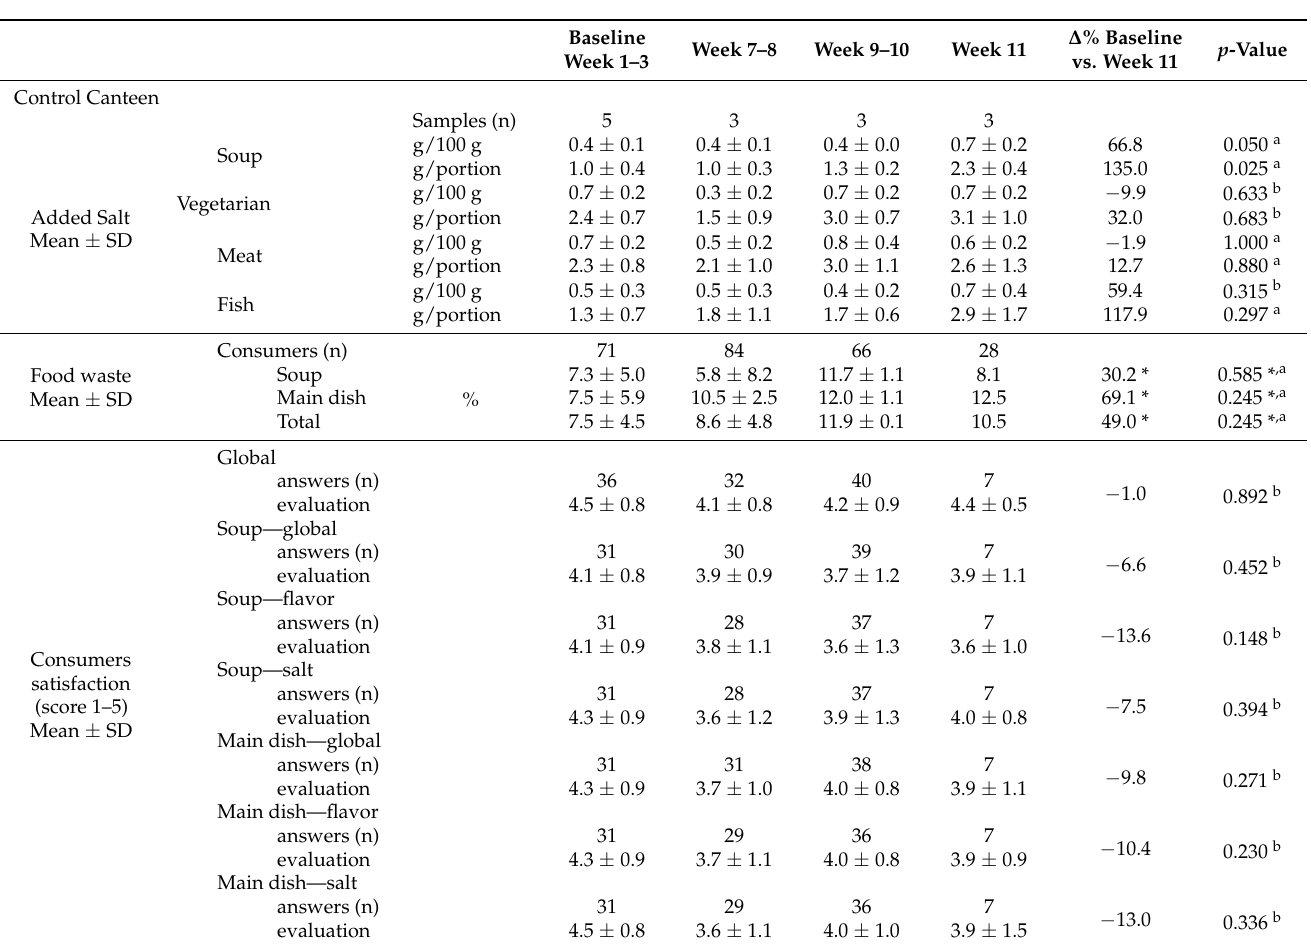
Table 1. Added salt, food waste and consumer satisfaction evaluations per canteen over the course of the